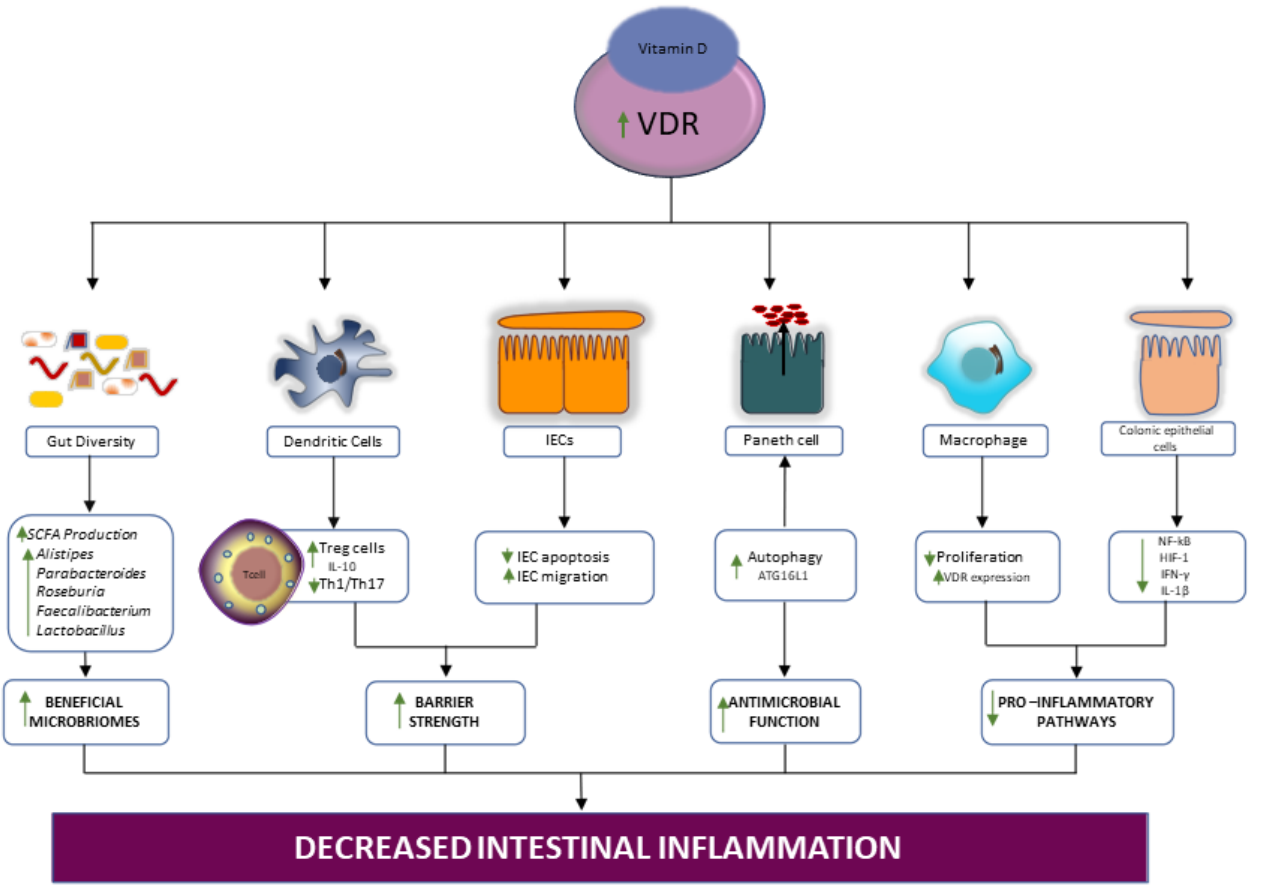
Figure 3. Action of vitamin D supplementation on the intestinal ecosystem. Vitamin D supplementation increases vitamin D/VDR signaling, which leads to an increase in SCFA-producing microbes, activation of proinflammatory Treg cells, inhibition of Th1/17 anti-inflammatory action, decreased intestinal epithelial cell (IEC) apoptosis and increased IEC migration, restoration of autophagy dependent Paneth cell action, increased macrophage proliferation and VDR expression, as well as reduction of anti-inflammatory cytokine action in colonic epithelial cells. (IEC, intestinal epithelial cell; IL, interleukin; Treg, T regulatory; Th, T helper; VDR, vitamin D receptor; NF- κ B, nuclear factor kappa B; HIF-1, hypoxia inducible factor; IFN, interferon).